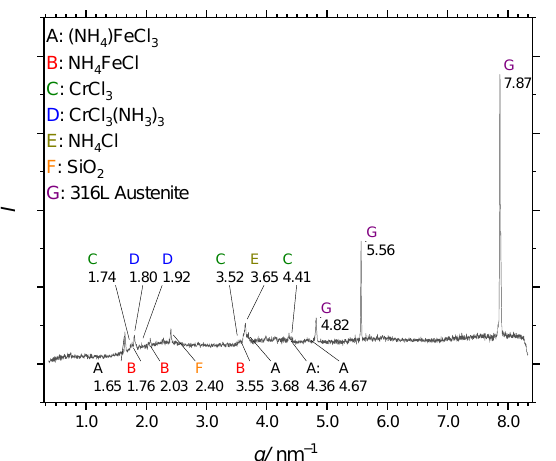
Figure 12. X-ray diffractogram of AISI-316L sample TX (activation T , no C ), confirming the presence of metal-ammine/ammonium chlorides.